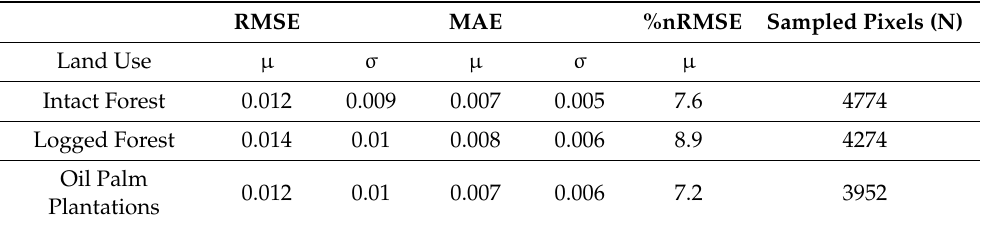
Table A2. Comparison of errors between simulated spectra with retrieved trait estimates as input and actual Sentinel-2 reflectance spectra stratified across land-use